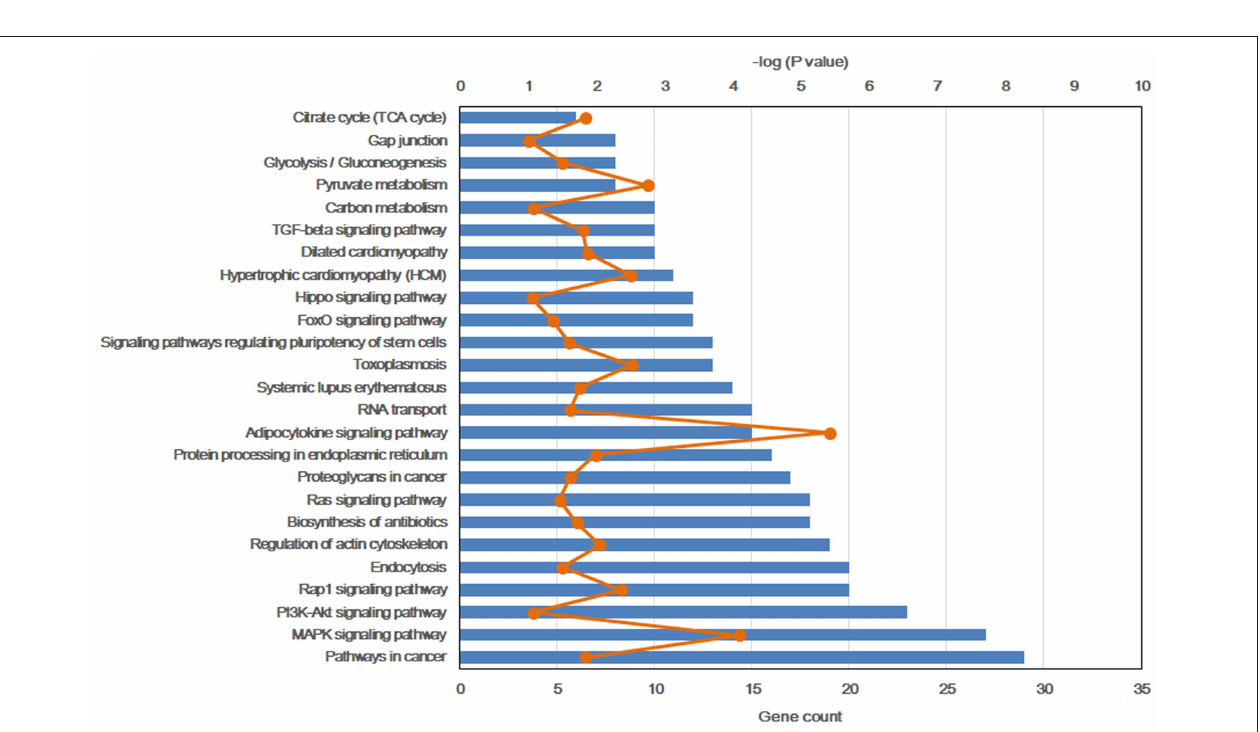
FIGURE 5 | Top 25 significant KEGG pathways of differentially methylated